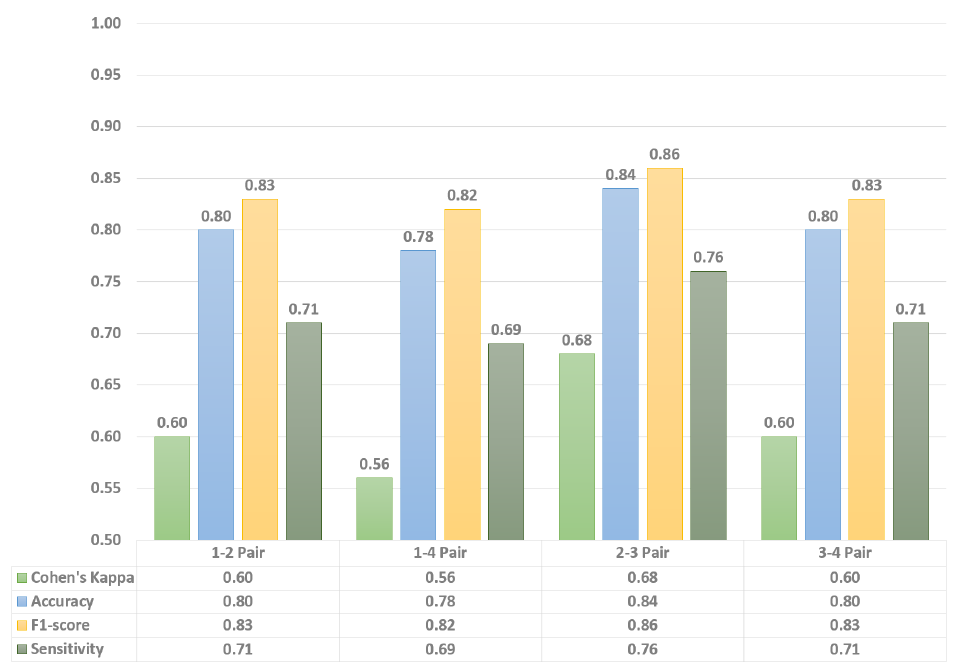
Figure 9. Comparison of performance in 2-bioradar system